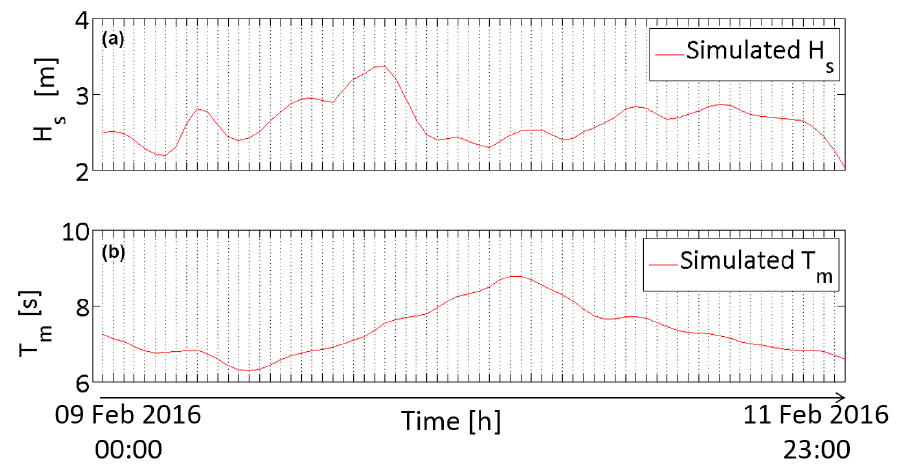
Figure 10. Simulated significant wave height ( H s , a ) and mean wave period ( T m , b ) relative to the 9–11 February 2016 sea storm at the virtual buoy near Bonassola beach. The simulations are carried out using the WW3 model configured with an hourly output time step.